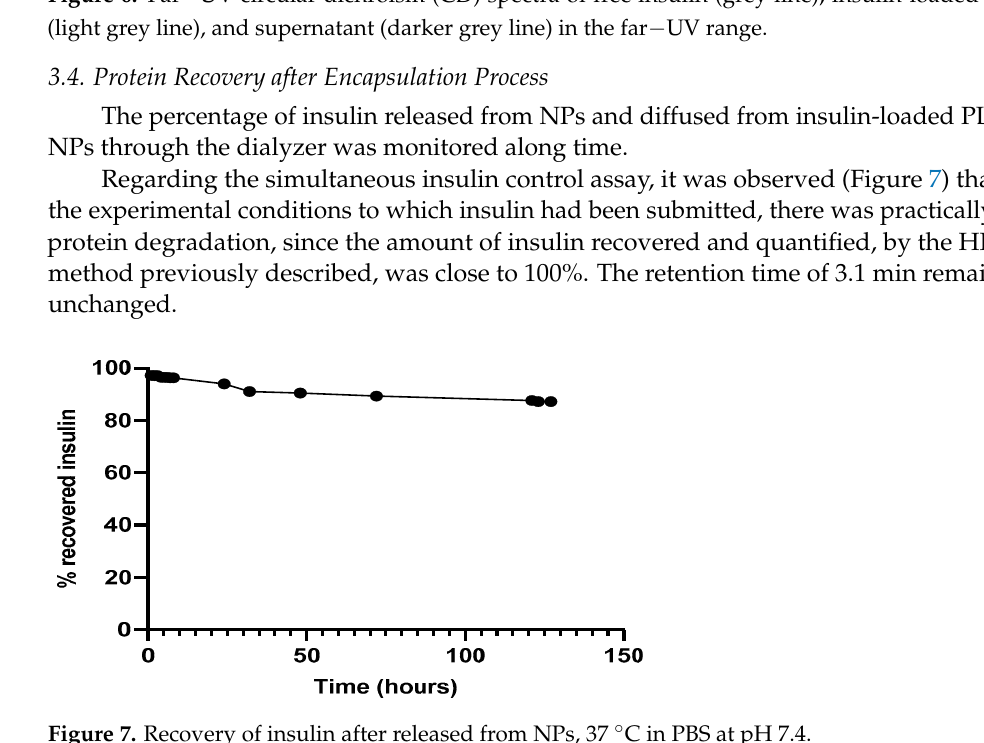
Figure 7. Recovery of insulin after released from NPs, 37 °C in PBS at pH 7.4. In Vitro Release Assay